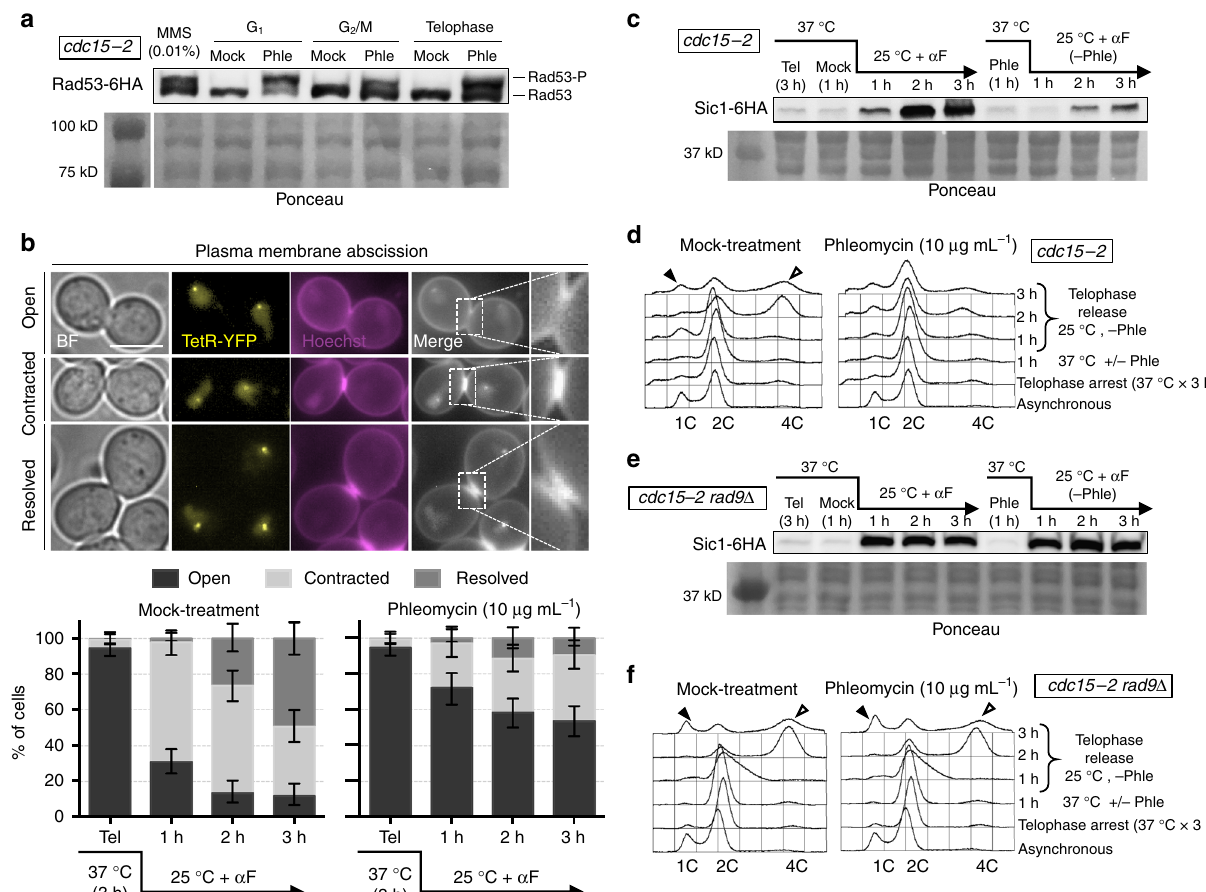
Fig. 1 Phleomycin triggers the DNA damage checkpoint to delay telophase-G 1 transition. a Rad53 gets hyperphosphorylated in telophase after